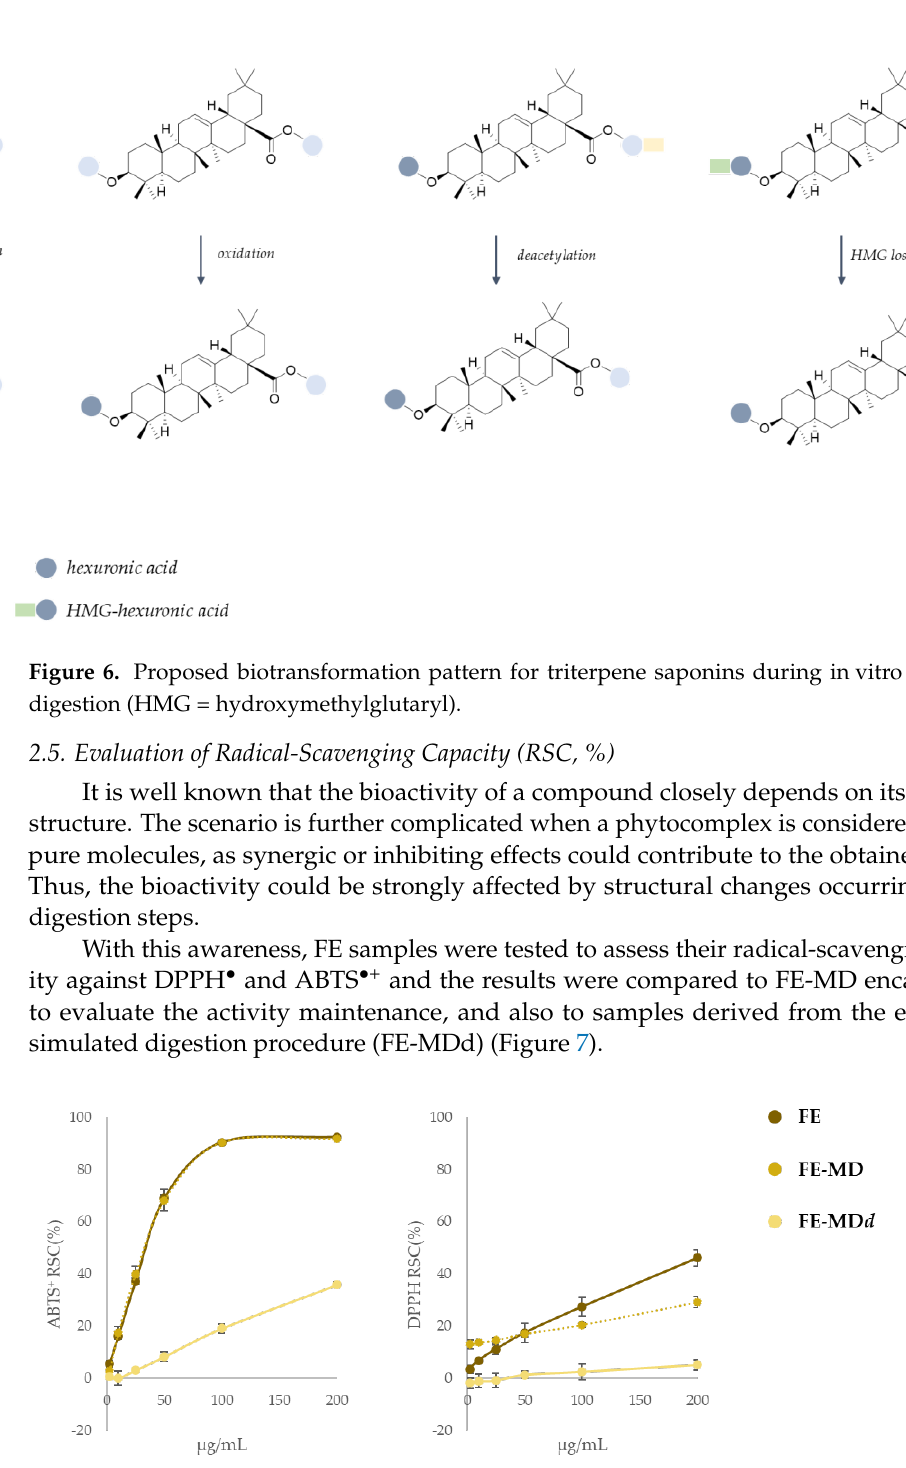
Figure 7. Radical-scavenging activity (RSC%) of floret extract (FE) in comparison with its encapsulate (FE-MD) and digested formula (FE-MDd) using DPPH and ABTS tests. Values reported are the mean ± SD of three independent measurements.